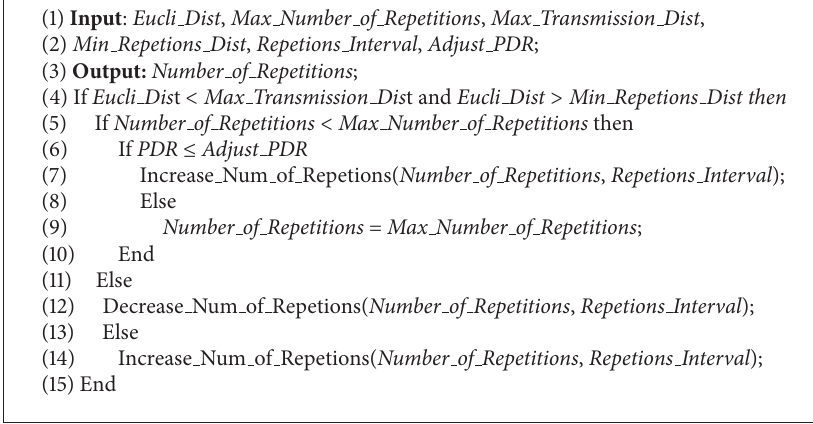
Algorithm 1: The repetition model decision algorithm based on intervehicle distance.